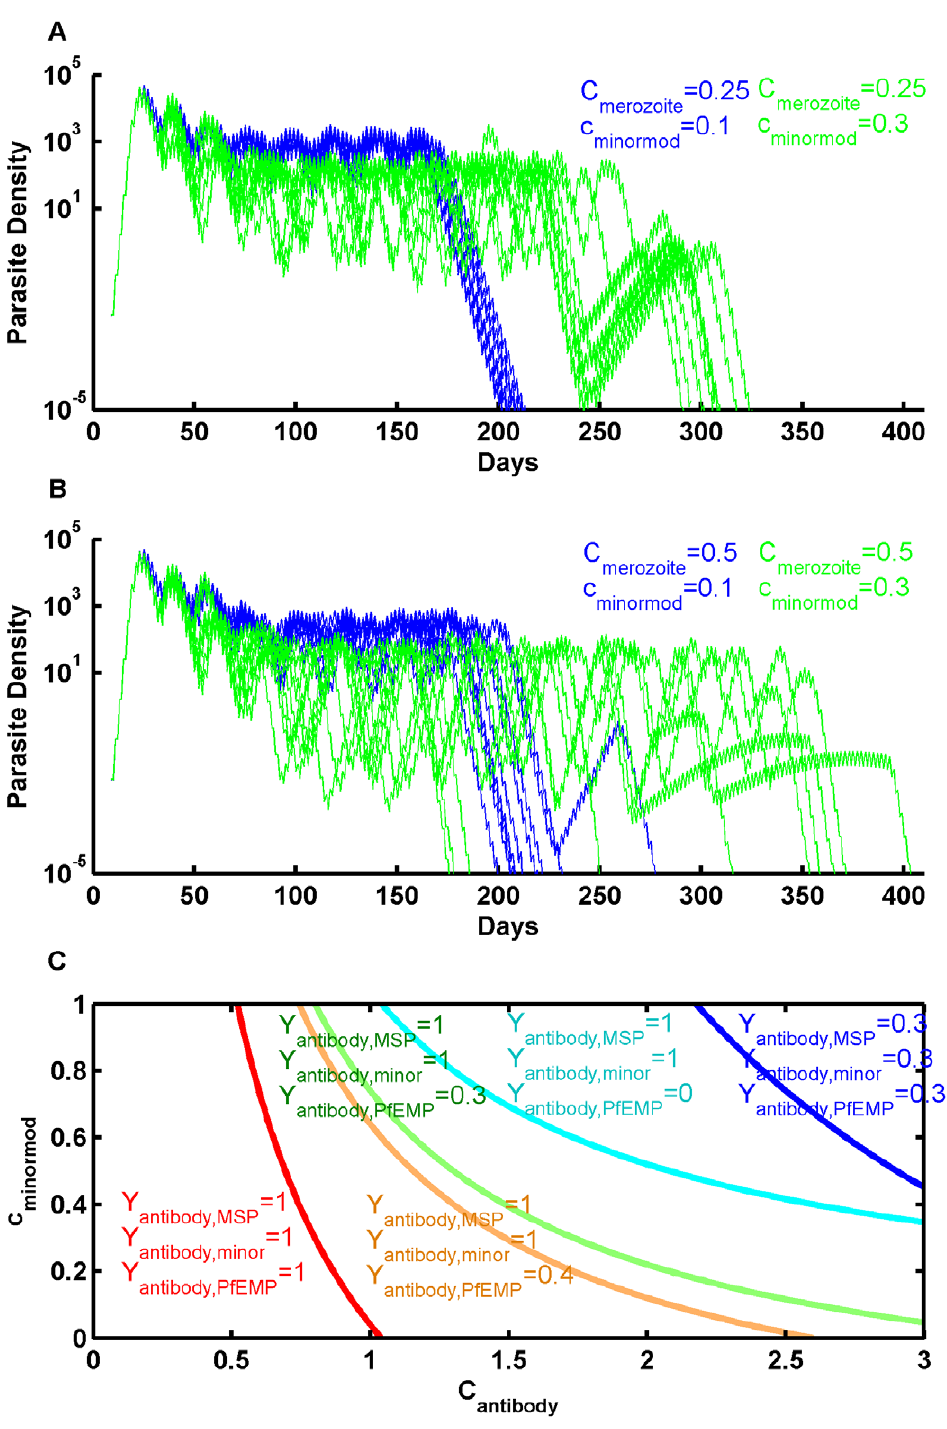
Figure 2. Effect of varying non-specific antigenicity c minormod and antibody kill rate C antibody on immune-parasite interactions. A,B) Simulated infection trajectories for different sets of immune parameters, for C antibody =1.5. Increased shared immunity reduces parasite densities, extends the duration of the first pass through the antigenic repertoire, and increases trajectory variability. C) Each curve corresponds to a level set of immune response which over a two-day cycle balances the merozoites per schizont. The red curve corresponds to maximum antibody levels, exhibited for Y antibody,MSP =1 for merozoite-specific immunity and Y antibody,i= 1 for the PfEMP-1 minor epitope-specific antigens. To the left of the red curve, no clearance occurs for any variant of the infection. The orange curve corresponds to Y antibody,MSP =1, Y antibody,i= 1 for minor epitope-specific antibodies, and 0.4 for PfEMP-1. The green curve is the same as before, but with Y antibody,i =0.3 for PfEMP-1 specific immunity, which is the level at which antibody is first released. The cyan curve is for Y antibody,i =0 for the expressed PfEMP-1 variant. To the right of this curve, new variants cannot grow in the presence of maximum non-specific antibody responses to merozoites and minor epitopes. Finally, the dark blue curve corresponds to Y antibody,i =0.3 for all three antibody responses. These curves can be used to constrain realistic parameter ranges.